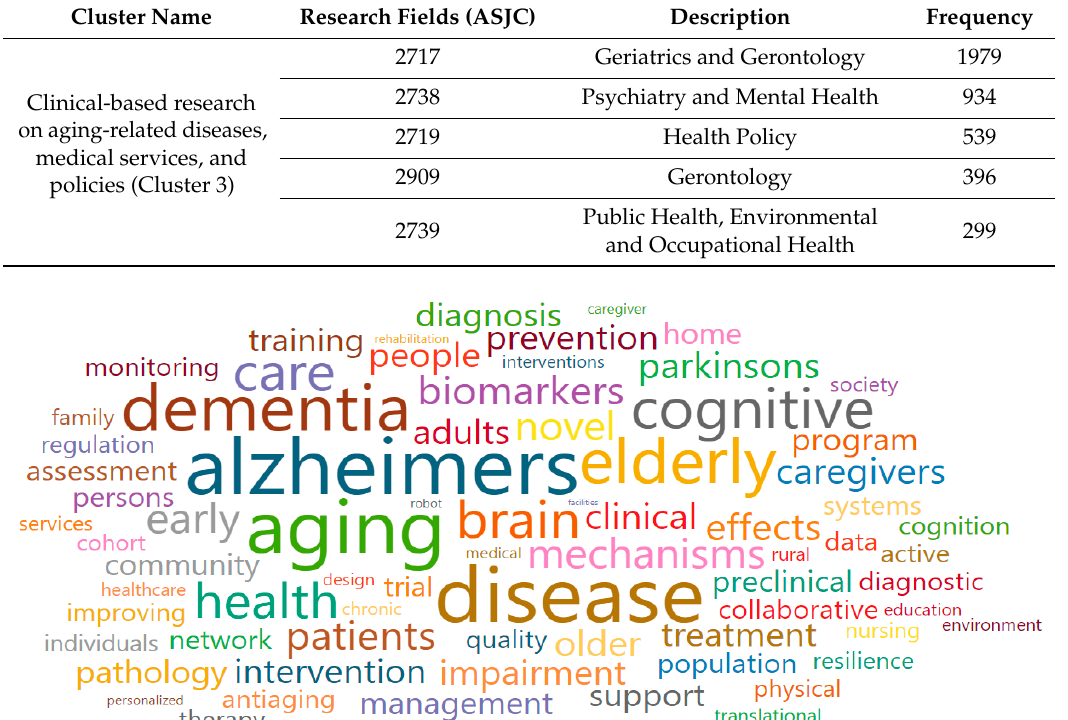
Table 4. Major research fields in Clinical-based research on aging-related diseases, medical services, and policies (Cluster 3).